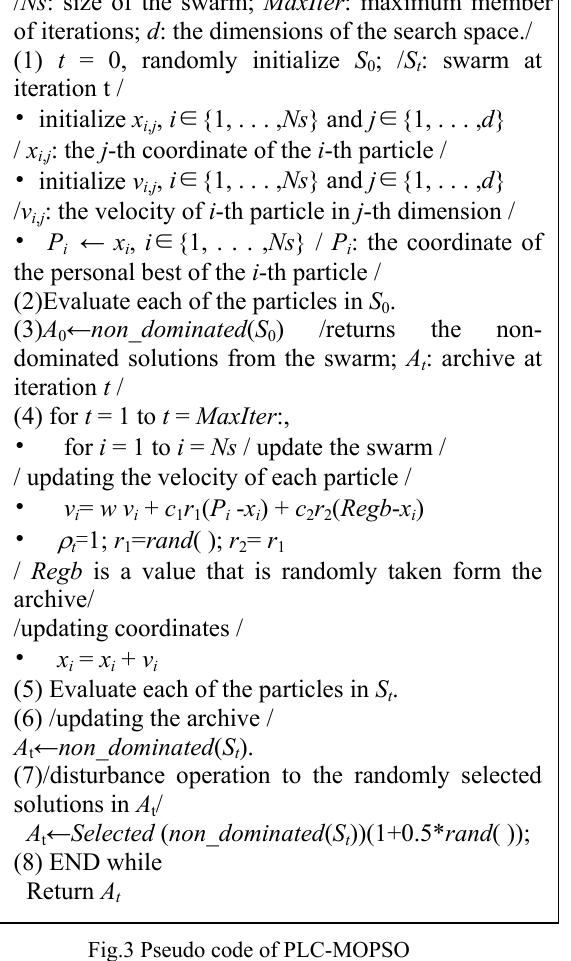
Fig.3 Pseudo code of